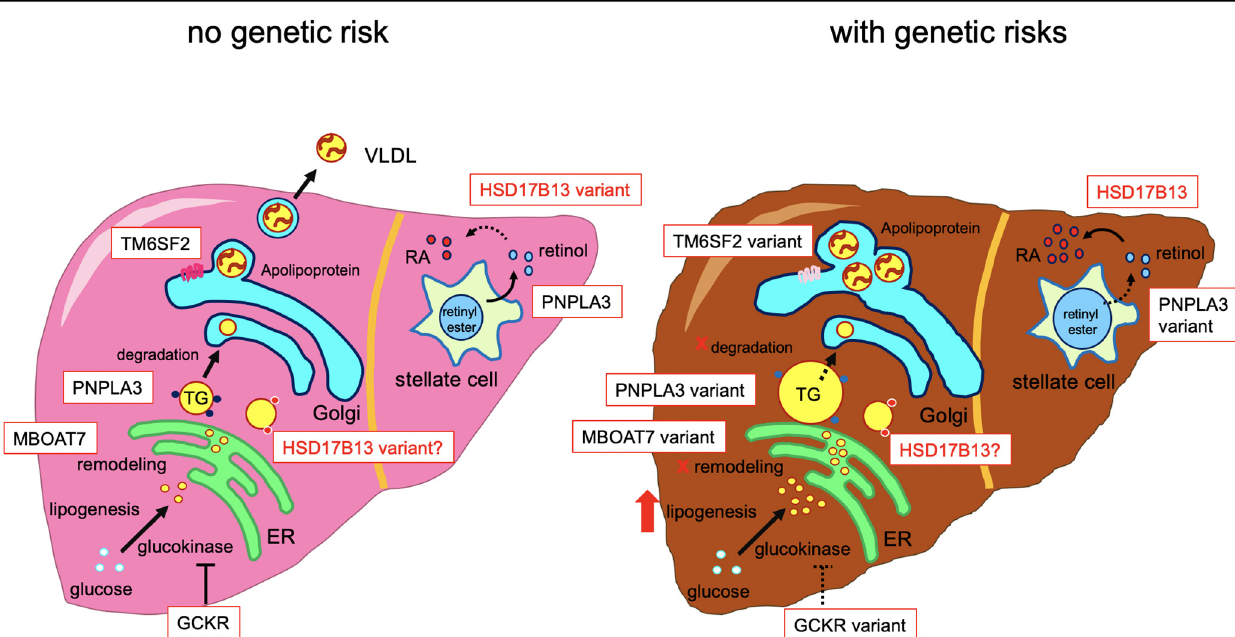
Figure 1. Molecular mechanism of genetic variants in FLD. HSD17B13 localizes at the surface of lipid droplets, but the function it serves there is still unknown. HSD17B13 also acts as a retinoic dehydrogenase, converting retinol into retinoic acid (RA). The HSD17B13 variants lose this function, which may protect the liver, but studies in stellate cells and their interactions with hepatocytes are still missing.